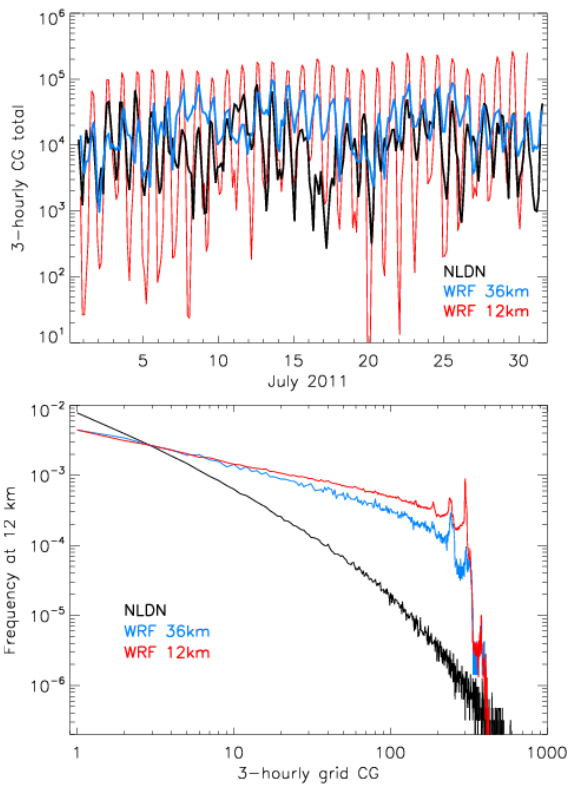
Fig. 10. Time series and frequency distributions of 3-hourly CG flash counts compared to NLDN at gridded to 12km. The WRF 36km distribution is adjusted by × 9 to account for the grid per area difference. The choice of computing the distributions for flash rate per grid as opposed to flash density is to demonstrate the consistency of the spectral drop-off at different resolutions.